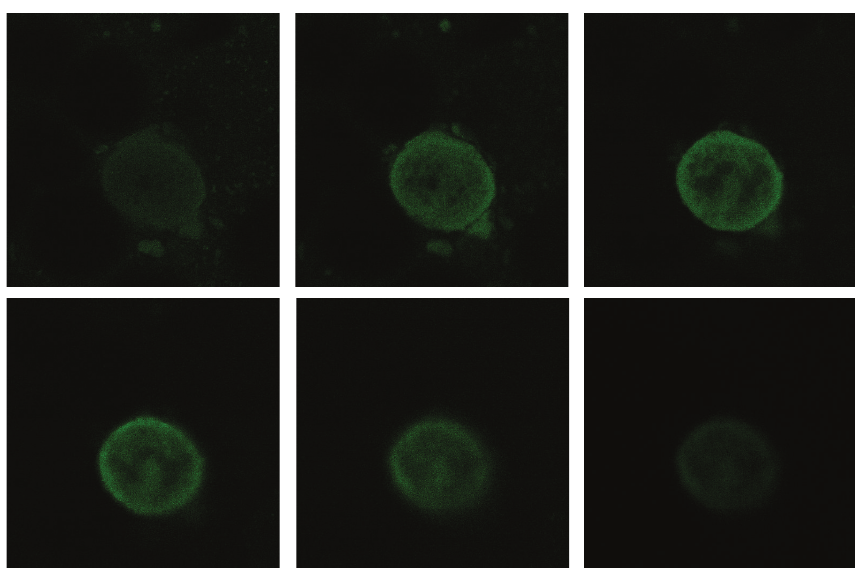
Figure 7: Confocal laser micrograph of hepatocytes incubated with FITC-PVLA coated SPIONs (1mg/mL) for 1 hour (gallery mode obser- vation).